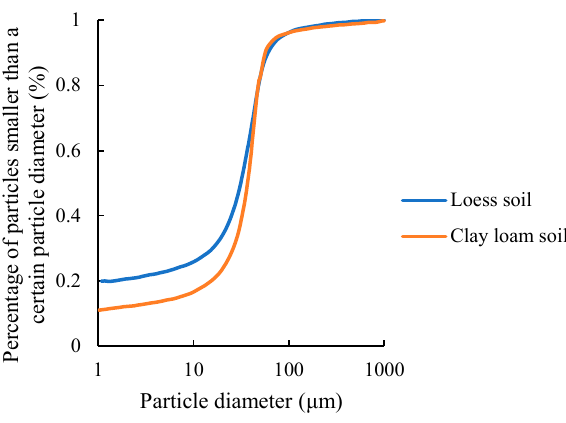
Figure 1. The grain size distribution curves of the soils.